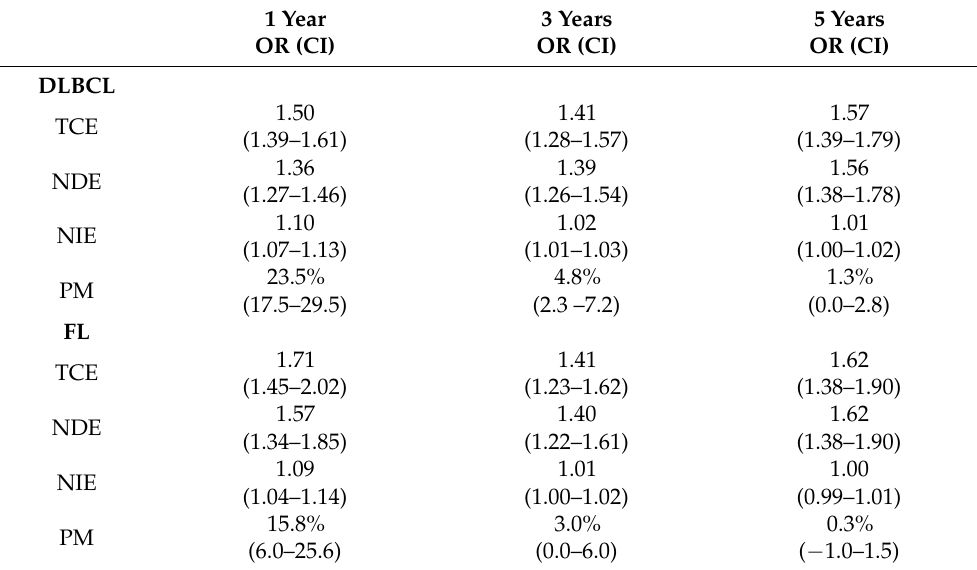
Table 3. Natural effect estimates for the odds ratio of conditional mortality since diagnosis, comparing comorbidity to no comorbidity mediated by diagnostic route, amongst patients diagnosed between 2005 to 2013 in England with DLBCL patients ( n = 27,379) or FL patients ( n = 14,043).